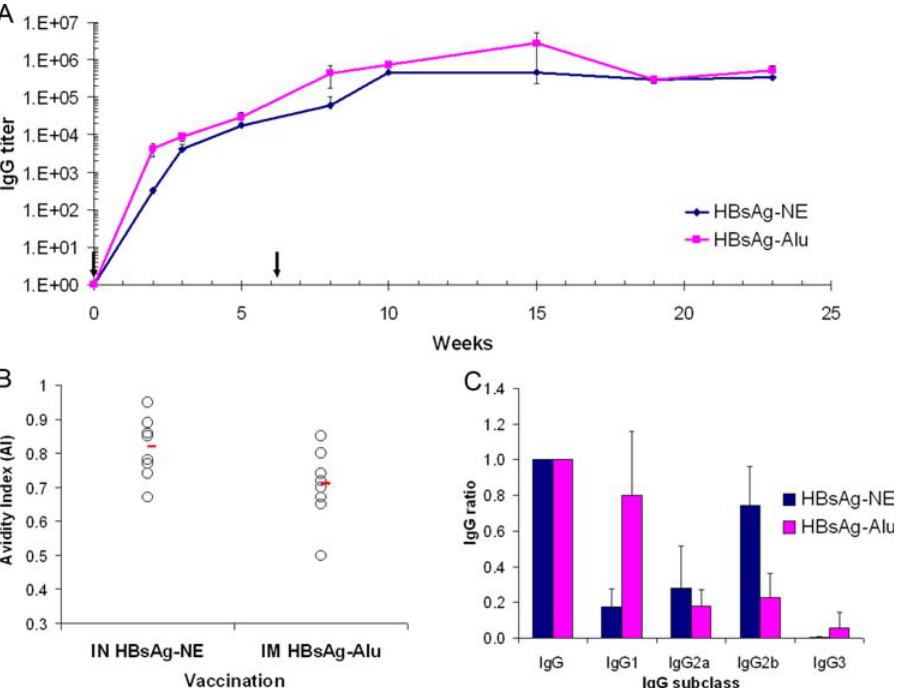
Figure 4. Comparison of mucosal NE-based with conventional aluminum-based injectible HBsAg vaccine. Time course of antibody response: Mice were immunized with 20 m g HBsAg. Antigen was mixed with 20% NE for intranasal administration (HBsAg-NE), or adsorbed on aluminum hydroxide (HBsAg-Alu) for intramuscular injections (A). Serum anti-HBsAg IgG antibody concentrations are presented as mean of endpoint titers in individual sera + / 2 SEM. * indicates a statistical difference ( p value , 0.05 ) in the anti-HBsAg IgG titers. Arrows indicate vaccine administration. Avidity of anti-HBsAg IgG: Analysis of sera from mice immunized i.n. with HBsAg-NE and with i.m. injections of HBsAg-Alu vaccines (B). Avidity indexes (AI) were assessed using 1.5 M NaSCN as a discriminating salt concentration. Each circle represents individual AI and lines indicate mean AI value for each group obtained in two independent assays. Serum anti-HBsAg IgG subclass: Anti-HBsAg IgG subclass pattern in mice immunized nasally with HBsAg-NE and injected i.m. with HBsAg-Alu vaccine (C). Analysis of sera collected at 22 weeks after initial immunization. The results are presented as ratio of the specific subclass IgG to the overall IgG titer. * indicates statistical difference ( p value , 0.05 ) between NE-based and alum- based